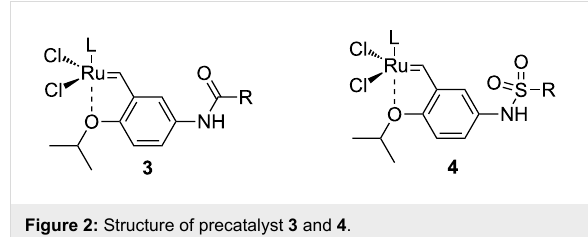
Figure 2: Structure of precatalyst 3 and 4